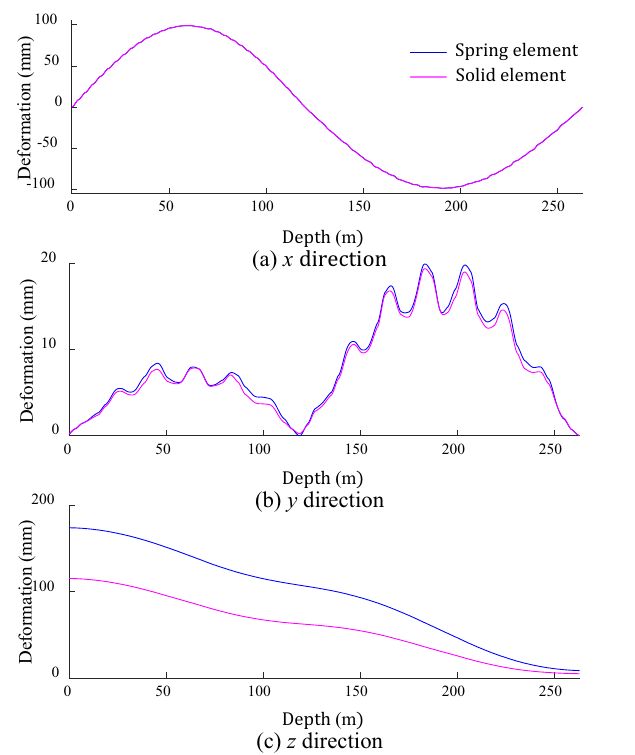
Figure 6. GRD under different calculation models.